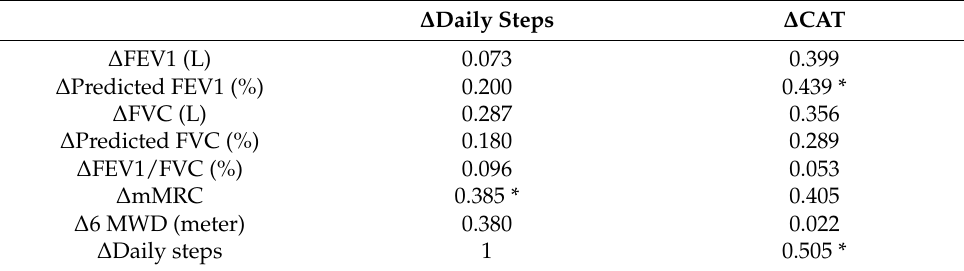
Table 4. The correlation between changes of parameters in all